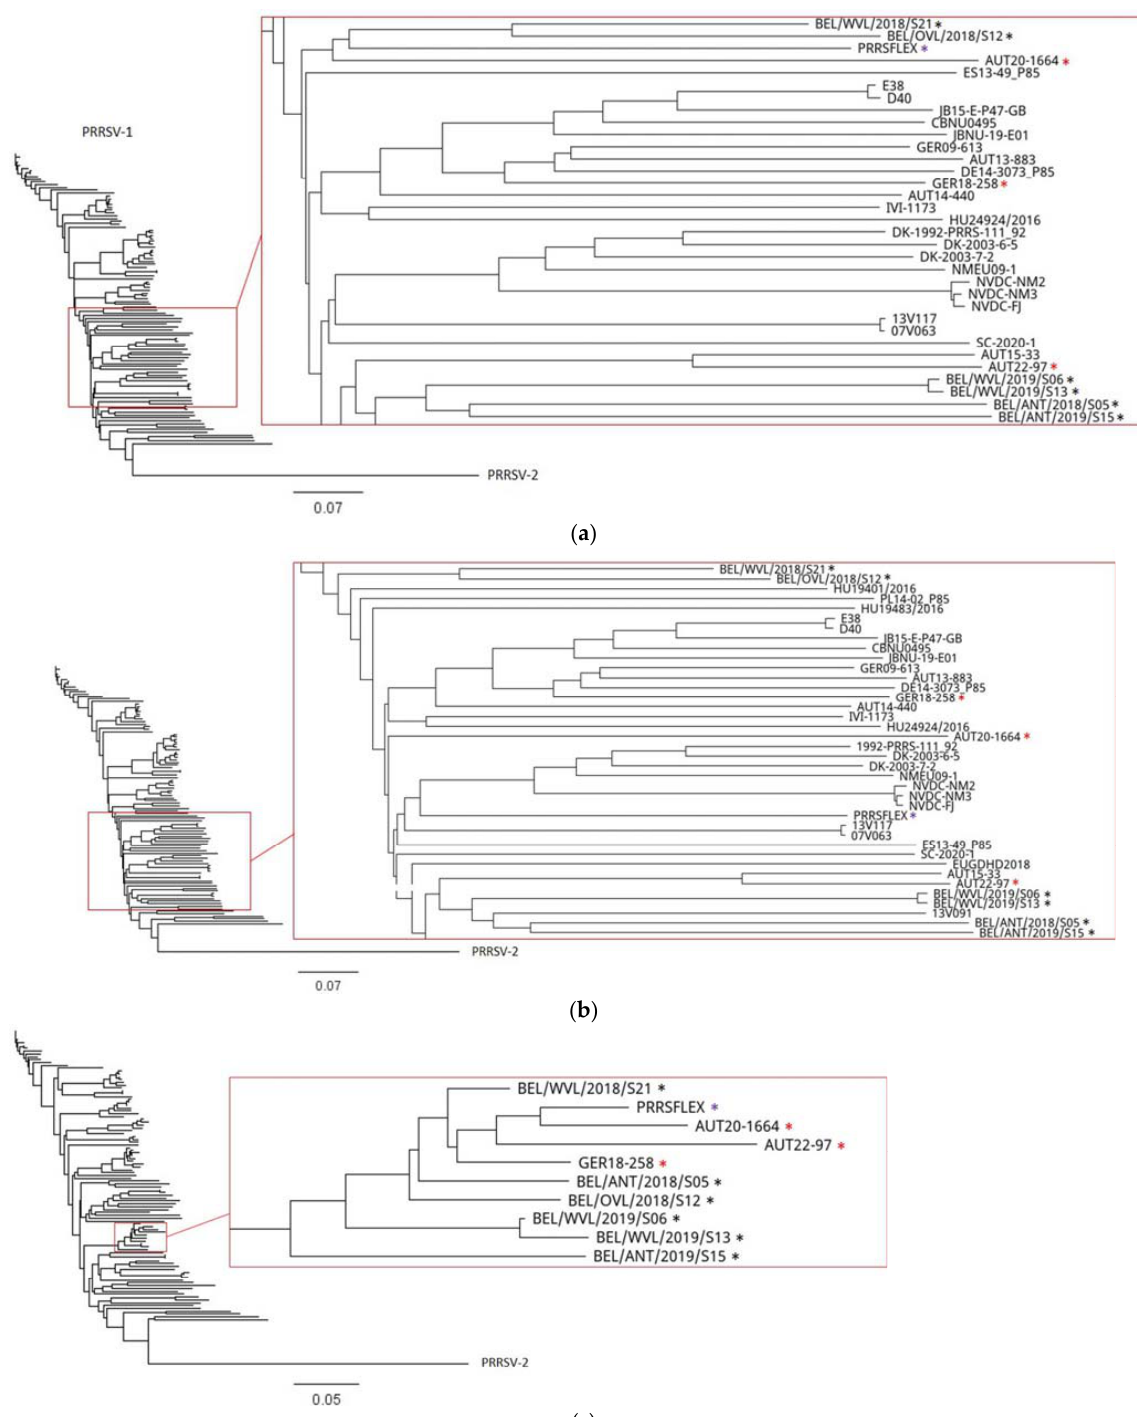
Figure 3. Phylogenetic trees of common PRRSV strains (Supplementary File S2) and our recombinant isolates (GER18-258, AUT20-1664, AUT22-97). The neighbor-joining method was used to generate trees of ( a ) whole genomes, ( b ) ORF1–4, and ( c ) ORF5–7. Individual PRRSV-2 strains are not shown, since our recombinants cluster is within PRRSV-1. Nucleotide distance was measured with the Jukes–Cantor model, and bootstrap analysis was performed with 100 replicates. Red asterisks mark our recombinant isolates, purple asterisk the Ingelvac PRRSFLEX ® EU strain, and black asterisks recombinant Ingelvac PRRSFLEX ® EU isolates described by Vandenbussche et al.